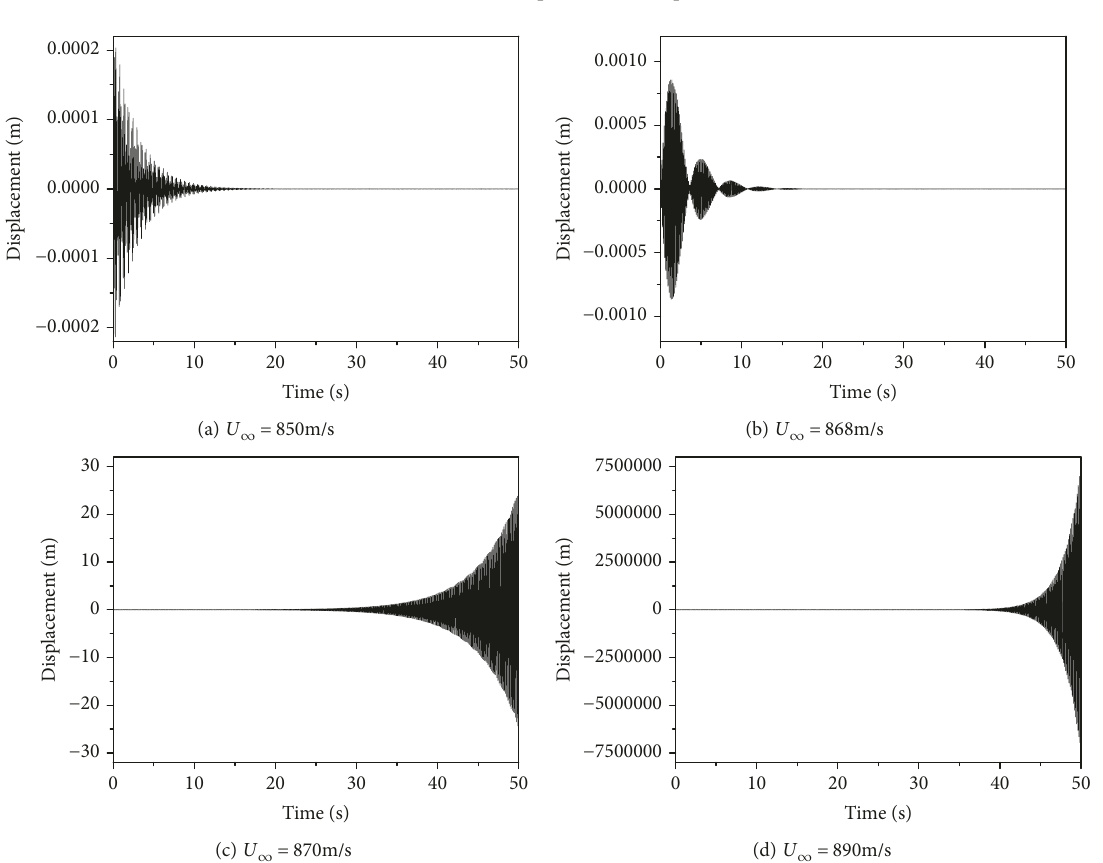
Figure 5: Vibration response of the S-S-S-S panel.